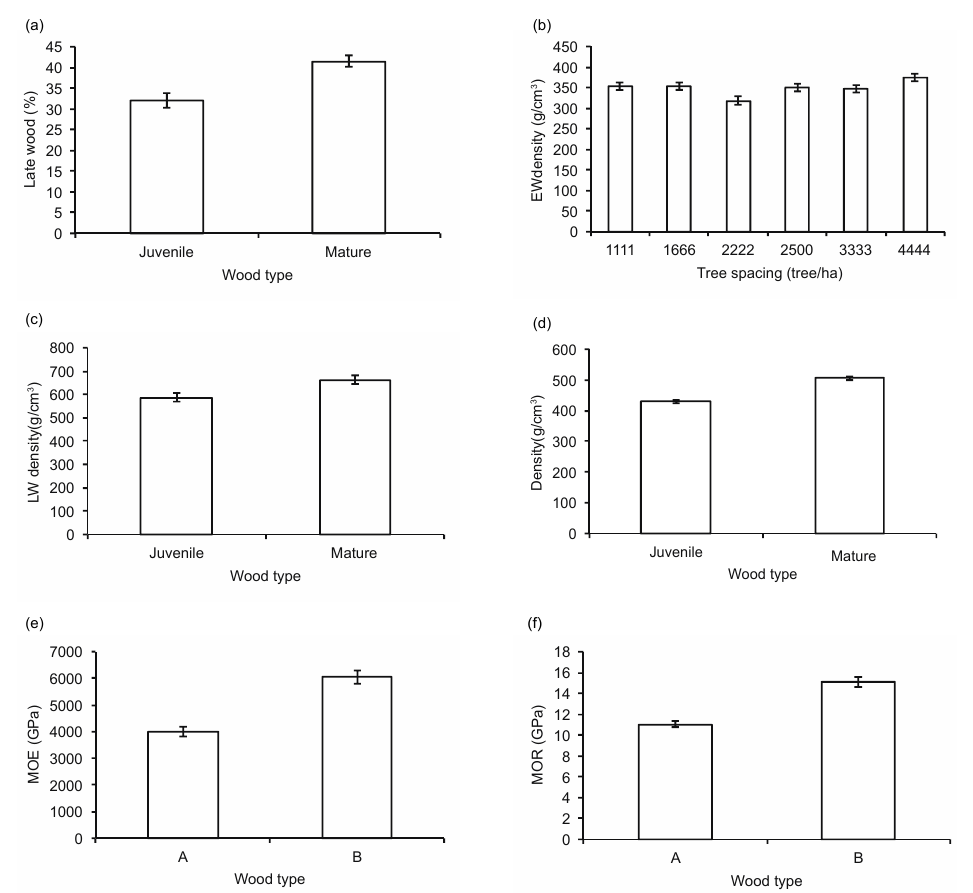
Figure 4. Effect of wood type on percentage of latewood ( a ); latewood density ( c ); mean wood density ( d ); modulus of elasticity (MOE) ( e ); modulus of rupture (MOR) ( f ); and effect of tree spacing on the earlywood density of juvenile wood ( b ) for jack pine 25 years following planting in Quebec, Canada. Data presented are the means (±SE).